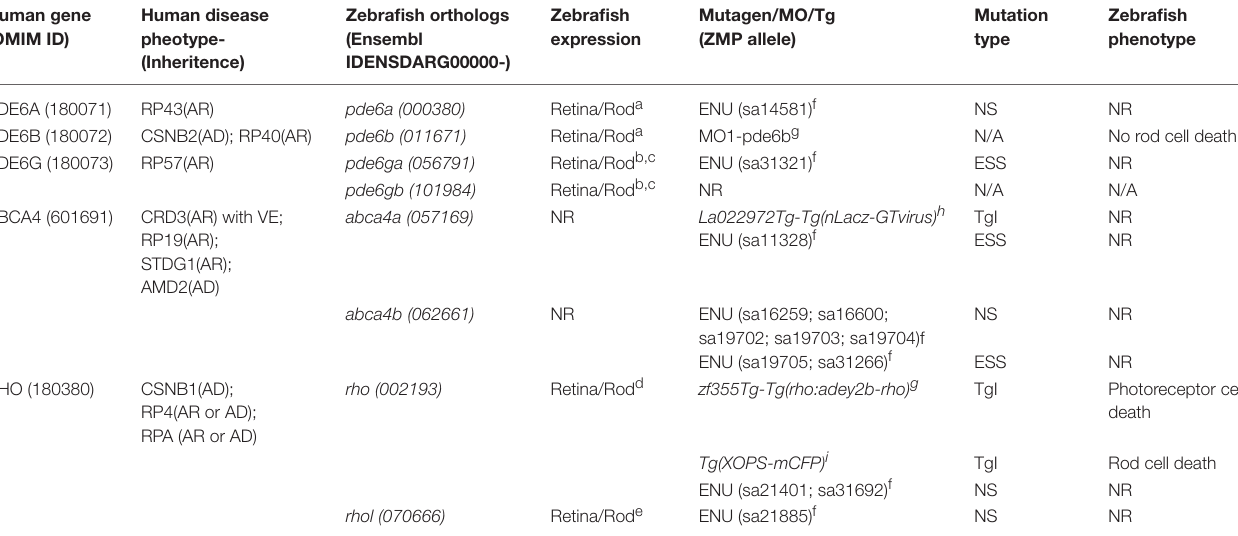
TABLE 1 | The five human RP-linked disease genes and eight corresponding zebrafish orthologs targeted in this study, their corresponding phenotypes and expression patterns in zebrafish and any available mutant, transgenic and morpholino-based zebrafish models. Human gene (OMIM ID)